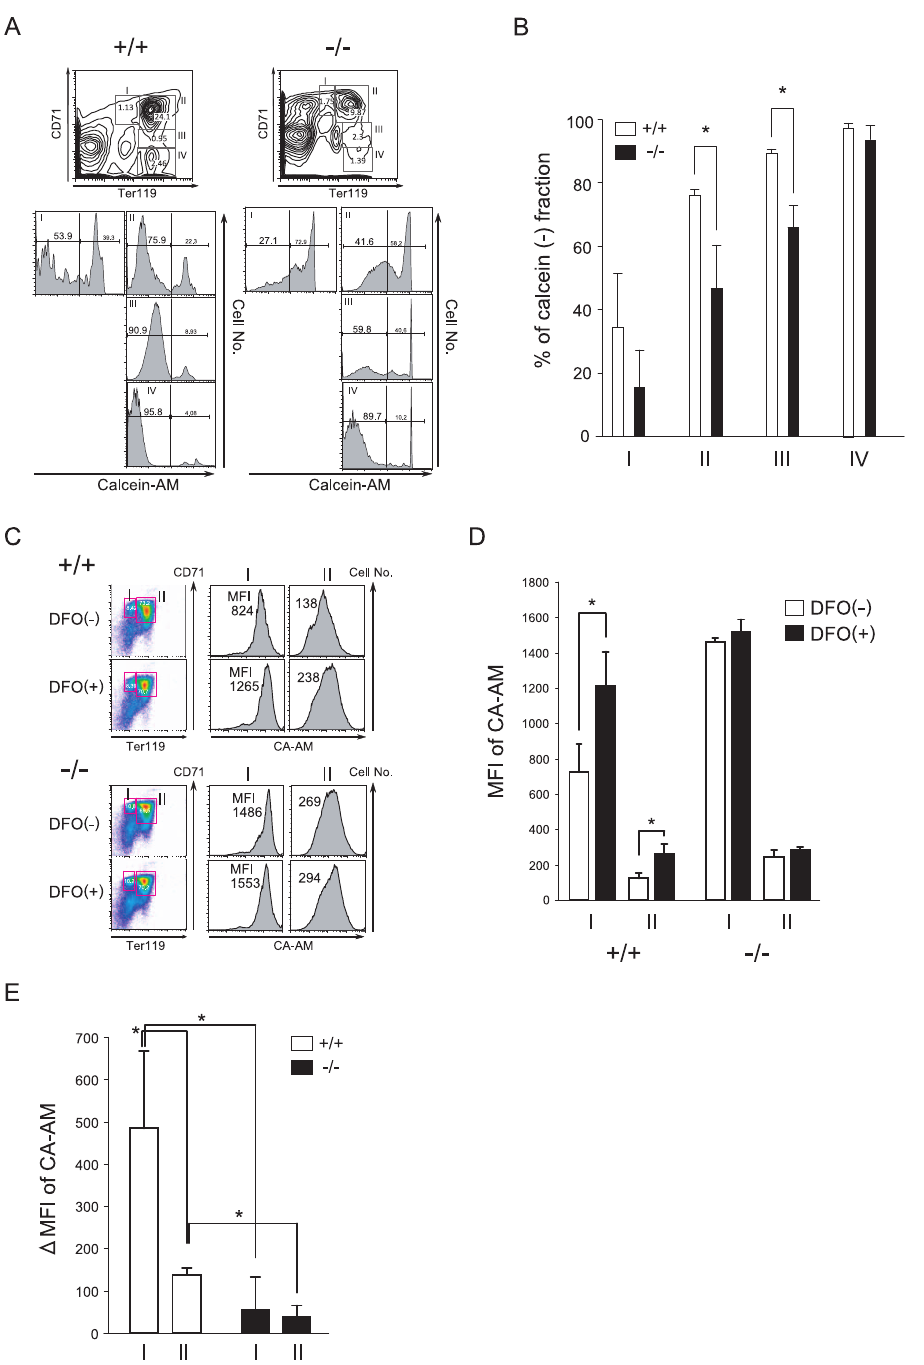
Figure 5. Flow cytometry analysis of the LIP. (A) Representative flow cytometry histograms. Erythroblasts at different stages of maturation were identified by double staining with APC-conjugated anti-TER119 and PE-conjugated anti-CD71 Abs (upper). These cells were simultaneously loaded with calcein (CA-AM) for the LIP assay (lower). (B) Quantification of CA-negative fractions in regions I to IV of (A) (data represent means 6 SD; n=3). (C) Representative flow cytometry histograms of E14.5 fetal liver cells. Erythroblasts at different stages of maturation were identified by double staining with APC-conjugated anti-TER119 and PE-conjugated anti-CD71 Abs. Cells were treated for 1 h with the iron chelator DFO, loaded with CA-AM for 10 min, and then analyzed. (D) Representative fluorescence (FL1-high) histograms of CA-stained cells treated with or without DFO are shown, along with mean fluorescence intensity (MFI). (E) The LIP is represented by the difference in MFI between DFO-treated and -untreated cells (data represent means 6 SD; n=3). *, P , 0.05 vs. control. In A, B, C and D, ( + / + ) and ( 2 / 2 ) represent wild-type and CALM -deficient mice, respectively.